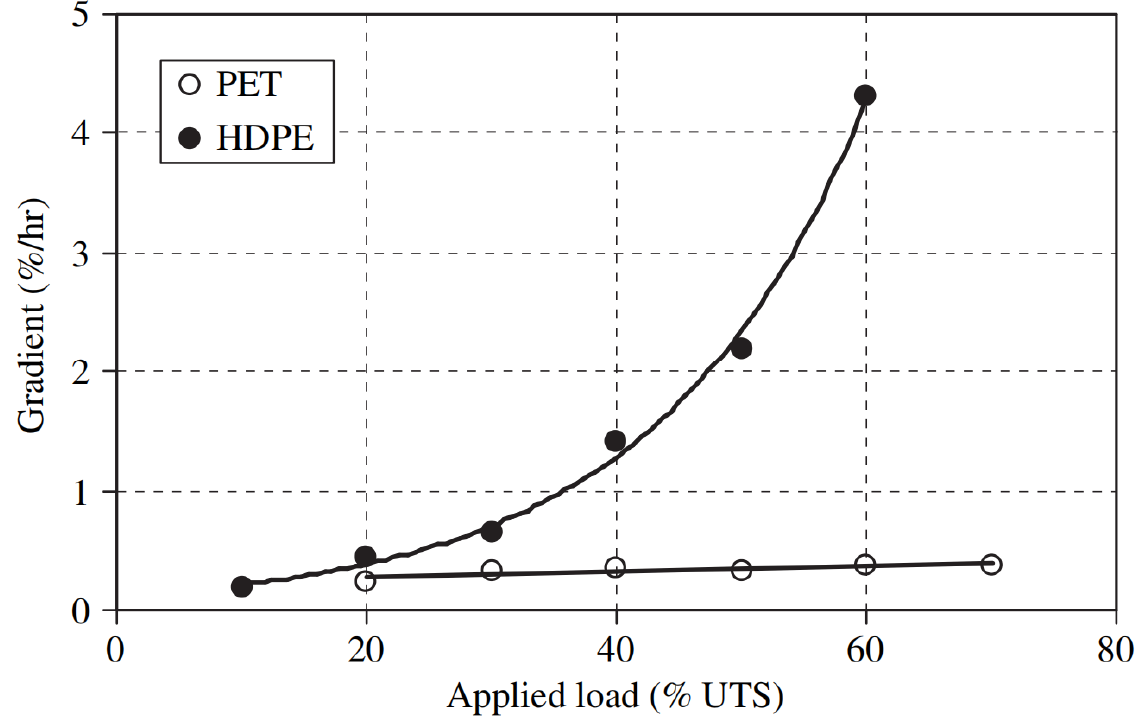
Figure 3. Creep strain rate vs. applied load for high-density polyethylene (HDPE) and polyethylene terephthalate (PET) geogrids [43].